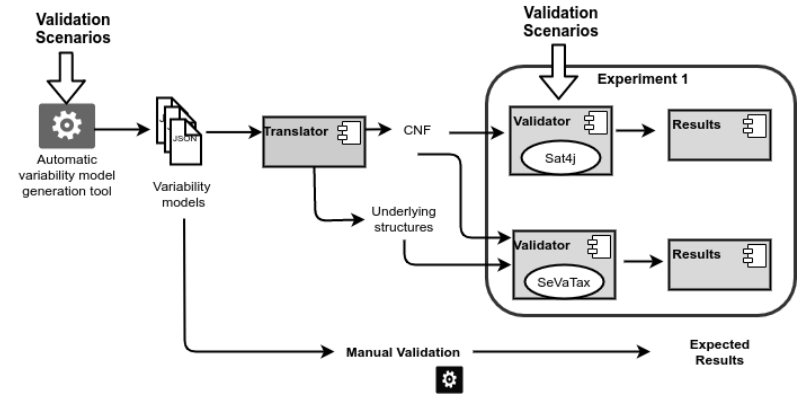
Figure 16. Experiment 1—Workflow for accuracy validation.